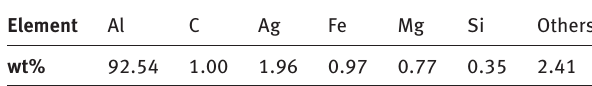
Table 1: Composition of aluminum used as matrix material